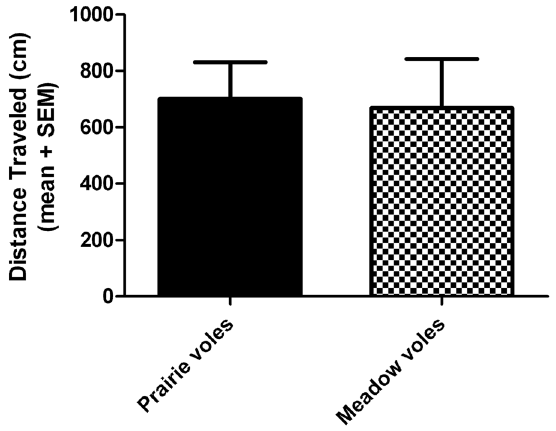
Figure 4. Locomotor activity during alcohol self-administra- tion. There was no difference between species in the total distance traveled per day, averaged across all four days of 4-hour access. Values indicate group mean + standard error of the mean